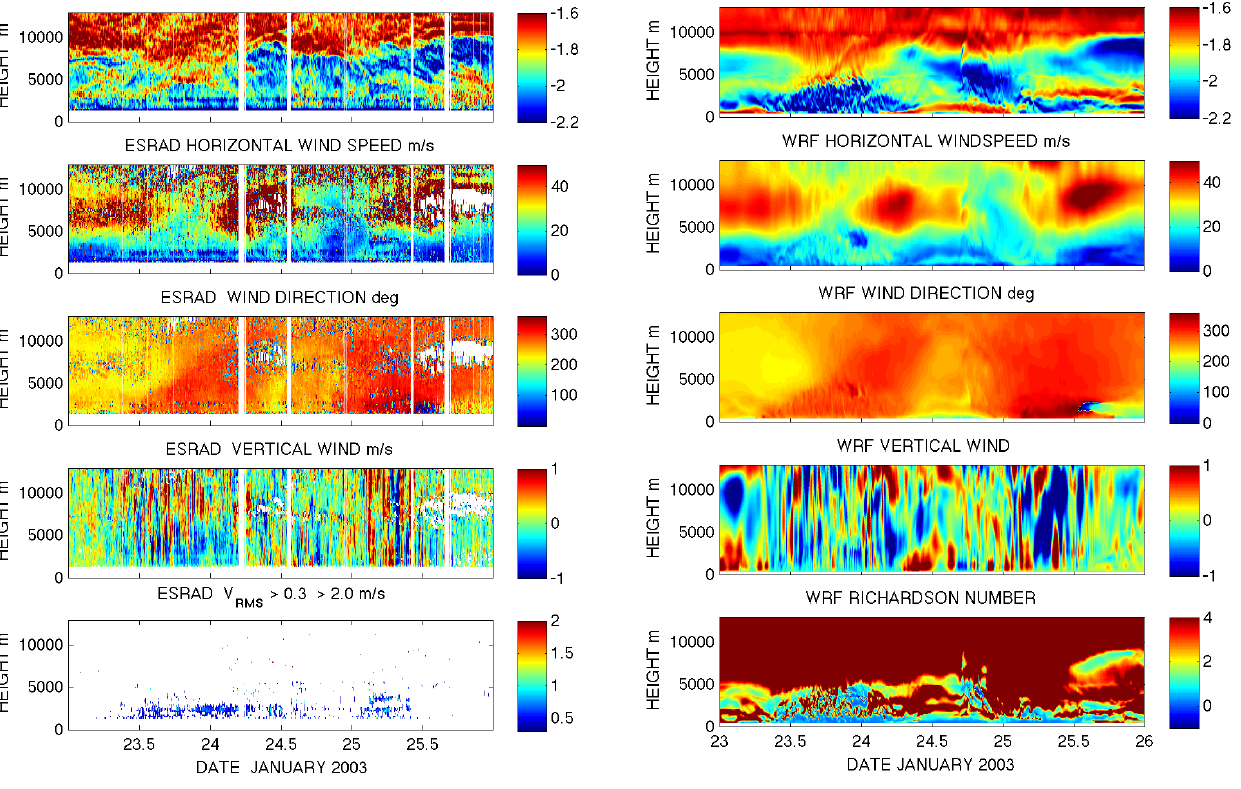
Fig. 5a. Measurements made by the ESRAD radar for 23, 24 and 25 January 2003. Gaps in the data due to interference, or low signal levels (signal-to-noise ratio < 0.5) are shown in white. Top panel shows the logarithm of the radar estimate of buoyancy frequency, R B . next two panels show the speed and direction of the horizon- tal wind (true wind from f.c.a. analysis). The direction from which the wind is blowing is given in degrees clockwise from north. The 4th panel shows the vertical wind from the Doppler shift of the radar echo (positive upwards). The lowest panel shows turbulent velocities ( V RMS ). Only values exceeding 0.3m/s are plotted below 5500m height, and values above 2m/s above that height.